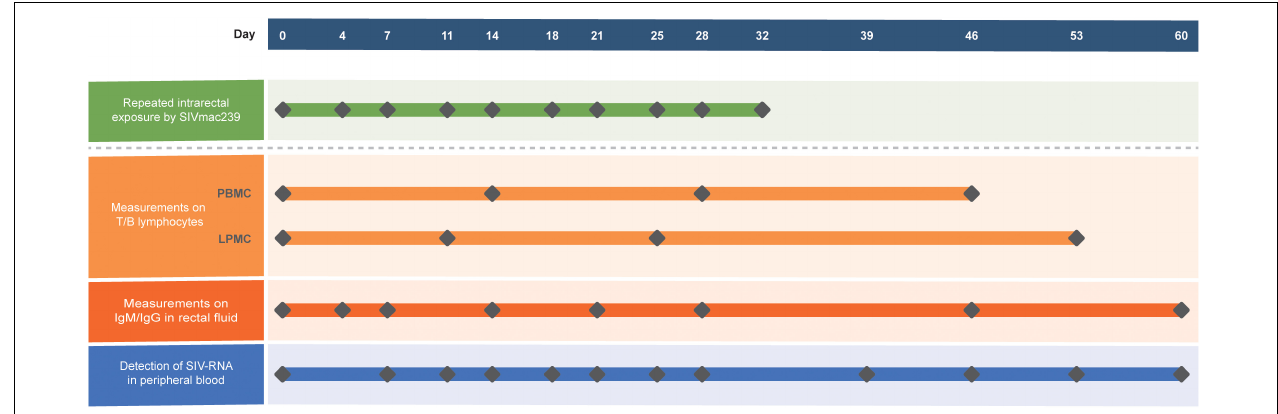
FIGURE 1 | Generation of the model using 10 ChRhs with periodical detection in the circulation and gut. Ten ChRhs were intrarectally exposed to low doses of SIVmac239 twice a week 10 times (along the green bar). T and B lymphocytes were measured at four time points in PBMCs or LPMCs at a short interval to minimize the impairment of the animals (along the light orange bar). Eight measurements of IgM and IgG were carried out in rectal fluid (along the dark orange bar). The plasma viral loads were detected 10 times (along the blue